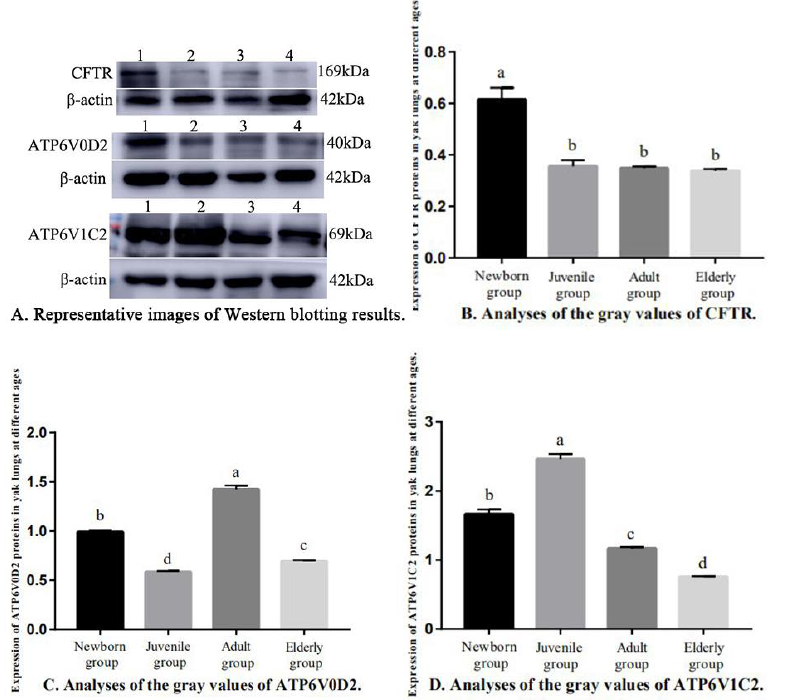
Figure 7. Relative Expression of CFTR, ATP6V0D2, and ATP6V1C2 proteins in yak lungs at different ages. ( A ) Representative images of Western blotting results. ( B ) Analyses of the gray values of CFTR. ( C ) Analyses of the gray values of ATP6V0D2. ( D ) Analyses of the gray values of ATP6V1C2. Note: 1. Newborn group; 2. Juvenile group; 3. Adult group; and 4. Elderly group. Different letters represent statistically significant differences ( p < 0.05).